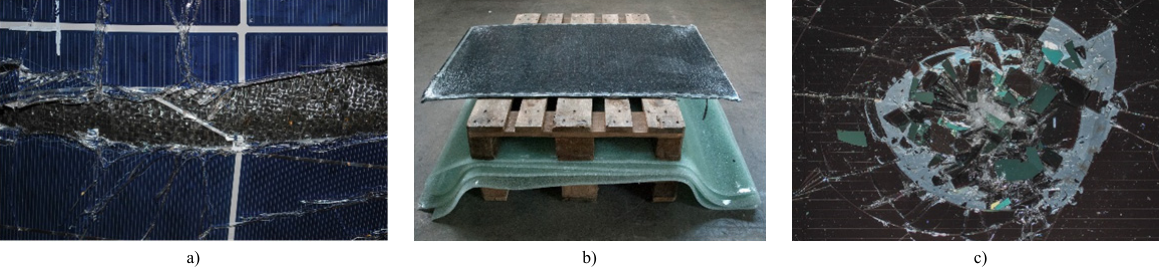
Fig. 13 Post breakage characteristics of a) PV wafer cell modules at +50 °C, b) PV modules with flexible thin-film cells in contrast to laminated safety glass made of thermally toughened glass without integrated PV cell layer and c) PV thin-film on glass superstrate